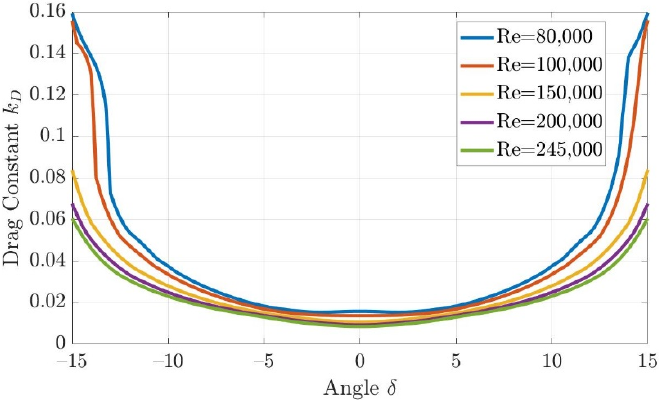
Figure 8. The drag constant k D with respect to turning angle δ .